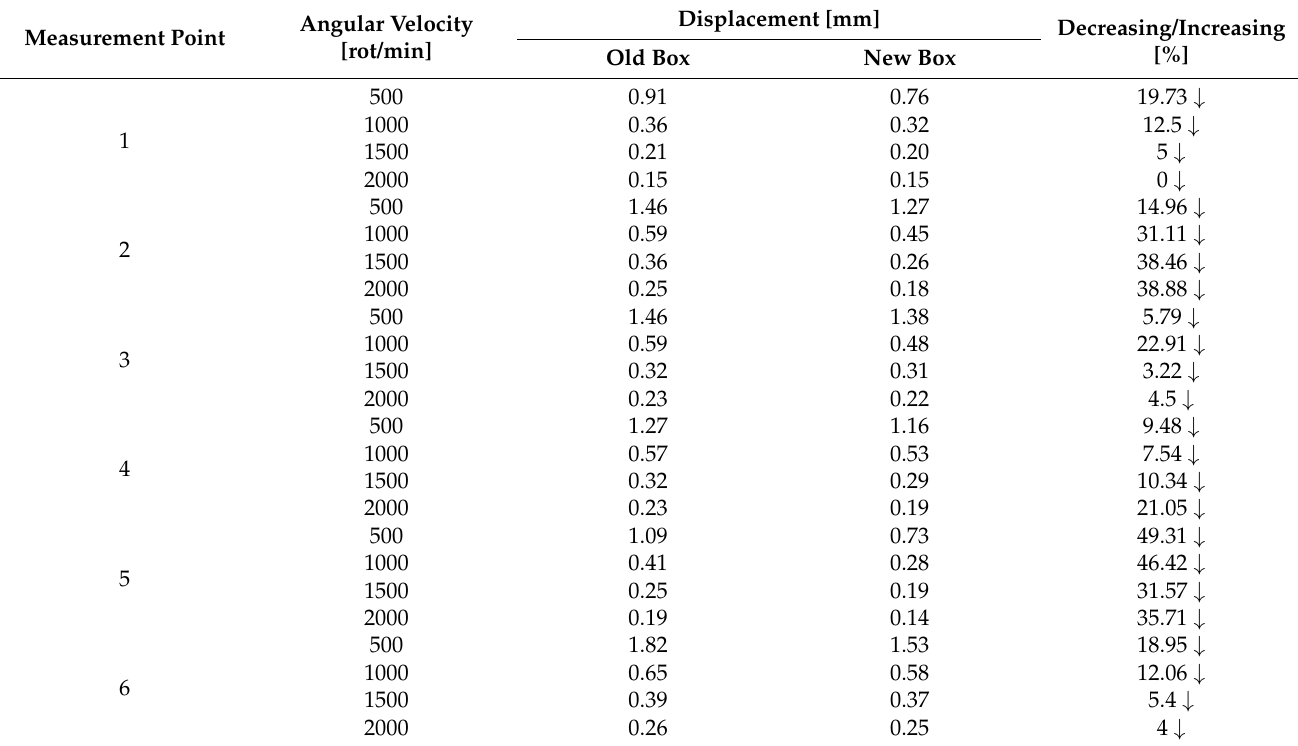
Table A3. The determined displacements on six points of the adder gearbox.